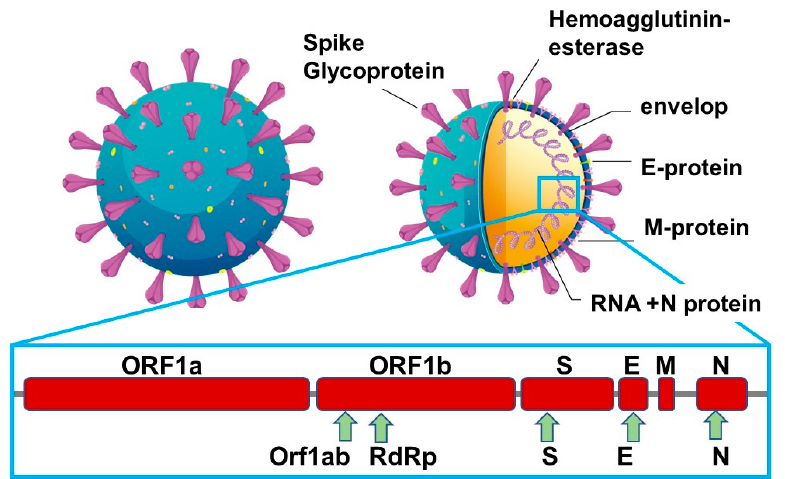
Figure 2. Structural proteins of SARS-CoV-2 for sensing: Viral replication requires other auxiliary genes, including open reading frame 1a (ORF1a), ORF1b and RNA-dependent RNA polymerase (RdRp).